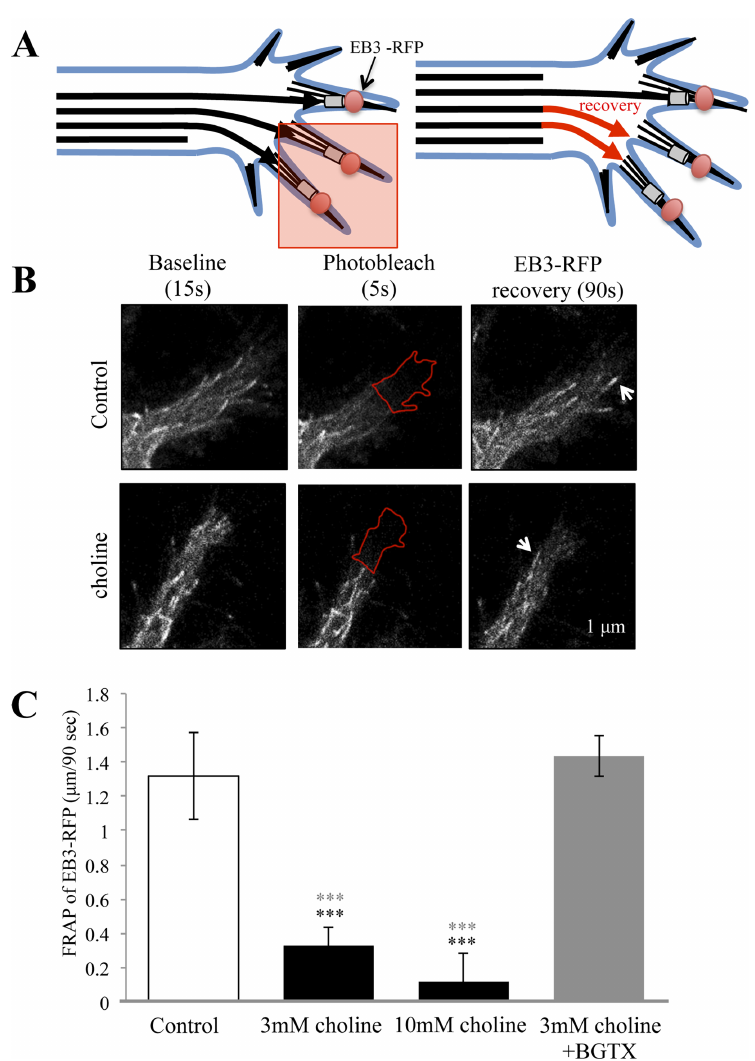
Fig 2. The α 7 nAChR directly attenuates in EB3 entry into the growth cone. (A) A schematic showing the fluorescence recovery after photobleaching (FRAP) assay. The red box indicates the photobleached area of the growth cone, while the red arrows represent EB3 comet re-entry into the bleached area during recovery. (B) Representative images of EB3 comets in the growth cone under Control (HBSS) and choline (3mM) treated condition during the experiment. Arrows point to the location of EB3 comets recovered after photo-bleaching in the ROI indicated by the red outline. (C) Average distance traveled by EB3 comets following photo-bleaching in Control, choline treated, and choline treated following BGTX application in cells. ( (cid:3)(cid:3)(cid:3) = p < 0.001; Black asterisks indicate comparison to control, Grey asterisks indicate comparison to 3 mM choline+BGTX treatment; n = 18 cells per group).